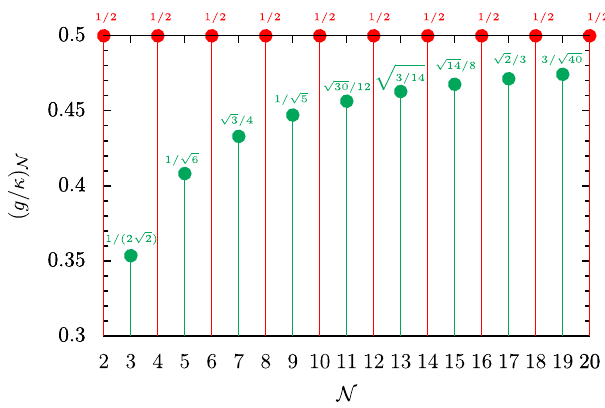
Fig. 6 Evolution of the exceptional point in arbitrary chains. The exceptional point ð g = κ Þ N as a function of the number of sites N in the oligomer chain [Eq. (29)]. Results with even (odd) N are associated with red (green)